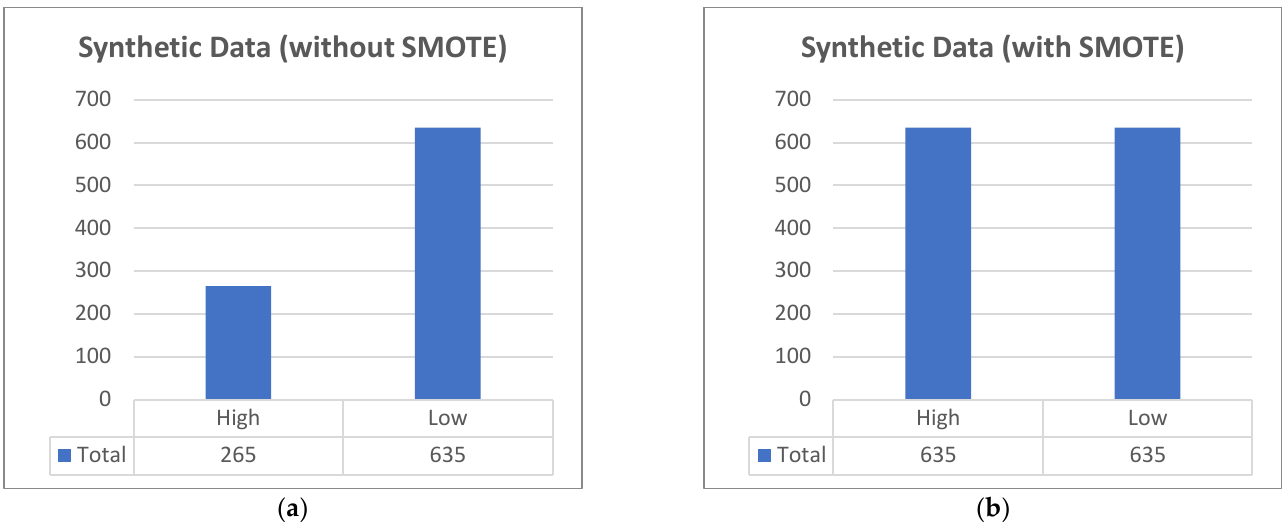
Figure 3. The synthetic data generated were also unbalanced. ( a ) Originally, there were 900 rows; there were more low-risk pregnancies than high-risk. ( b ) Using SMOTE, both classifications are now equally 635 rows, totaling 1270 rows.